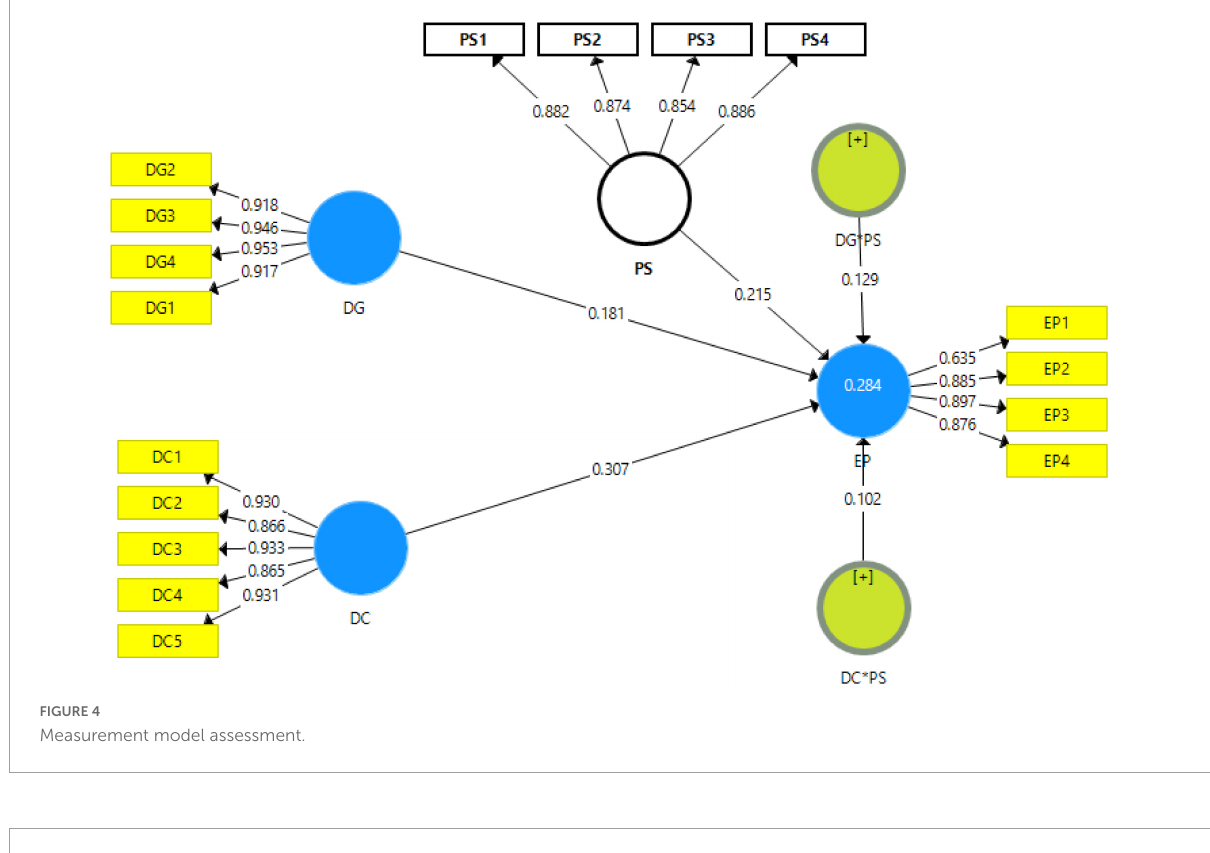
FIGURE4 Measurement model assessment.